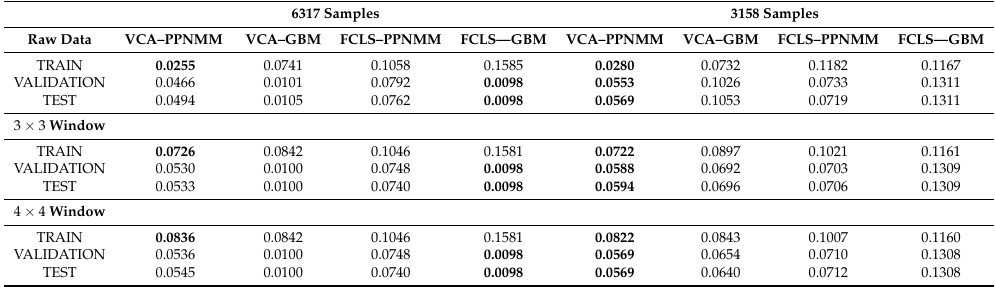
Table 7. Abundance estimation error on Samson data showing training, validation and testing accuracy on the individual and hybrid methods with different training samples and different window size vectors. The best results are shown in